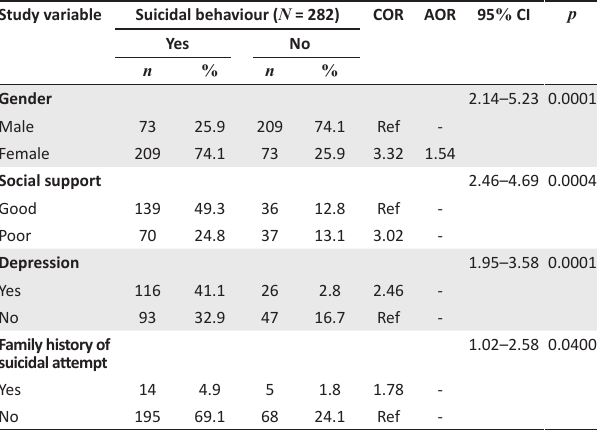
TABLE 3: Odds ratio of suicidal behaviour. Study variable Suicidal behaviour ( N =